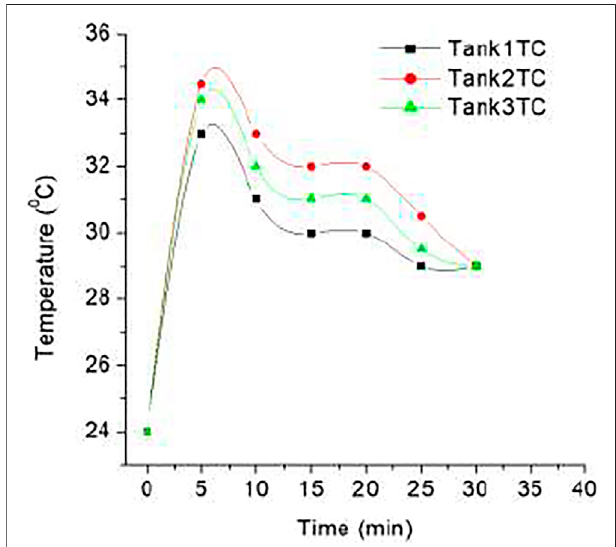
FIGURE 3 | Hydrogen charging curves of three MH tanks at 20 ° C.